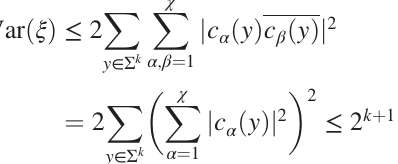
FIG. 2. Quantum circuit R used to estimate the real part of h ϕ α j Π ð y Þj ϕ β i in Eq. (3). The final output of the circuit is a random variable σ 0 ¼ (cid:2) 1 such that σ 0 ¼ 1 if and only if y; α ; β y; α ; β b ¼ 0 and f ð yz Þ ¼ 1 , where f : f 0 ; 1 g n þ k → f 0 ; 1 g is the Boolean function describing the postprocessing step in the original circuit U on n þ k qubits. We construct a circuit R as above for each triple ð y; α ; β Þ , with y ∈ f 0 ; 1 g k and α ; β ¼ 1 ; … ; χ . A simple algebra shows that σ 0 is an unbiased y; α ; β estimator of Re ½h ϕ α j Π ð y Þj ϕ β i(cid:3)